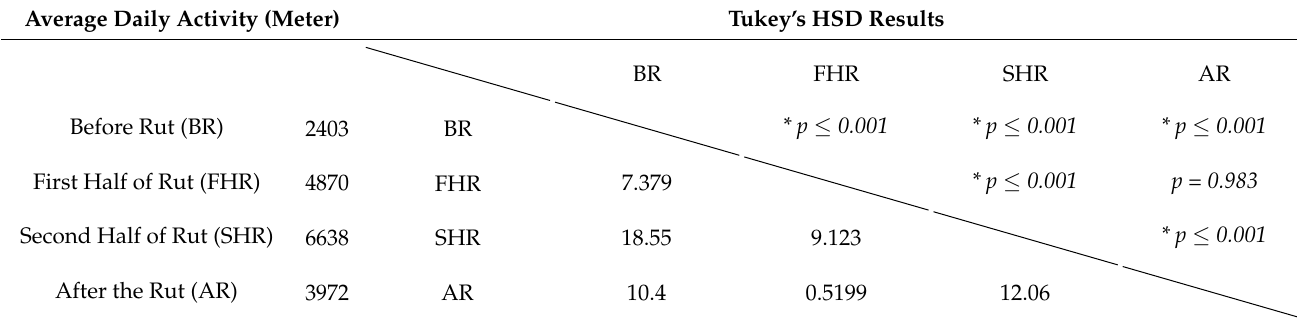
Table 1. The result of analysis of average daily activity.